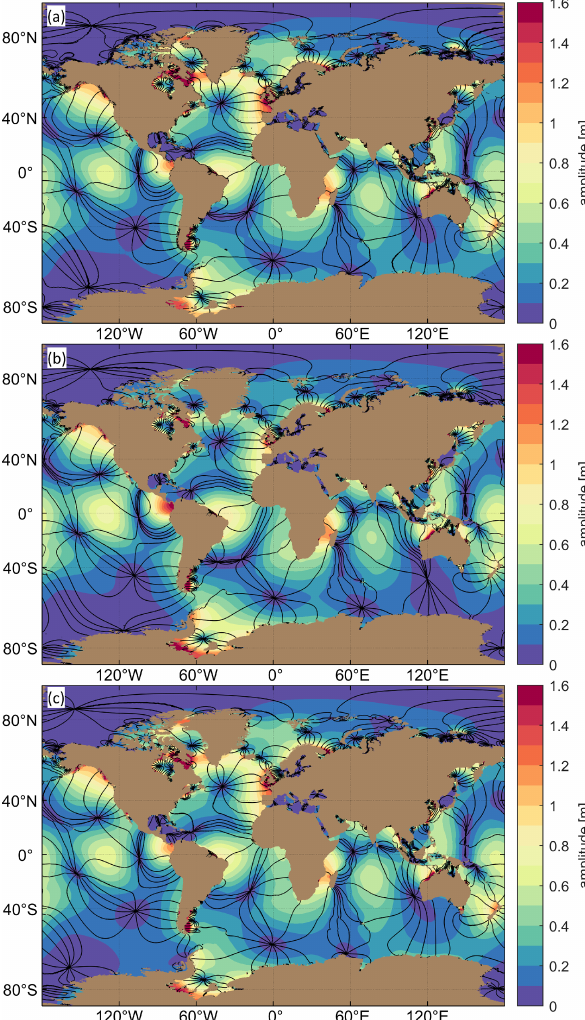
Figure 6. Global M 2 RMSE t computed against the TPXO9-Atlas for (a) ADCIRC v54 on the Ref mesh, (b) ADCIRC v55 upgrade on the Ref mesh, and (c) ADCIRC v55 upgrade on the TLS-B